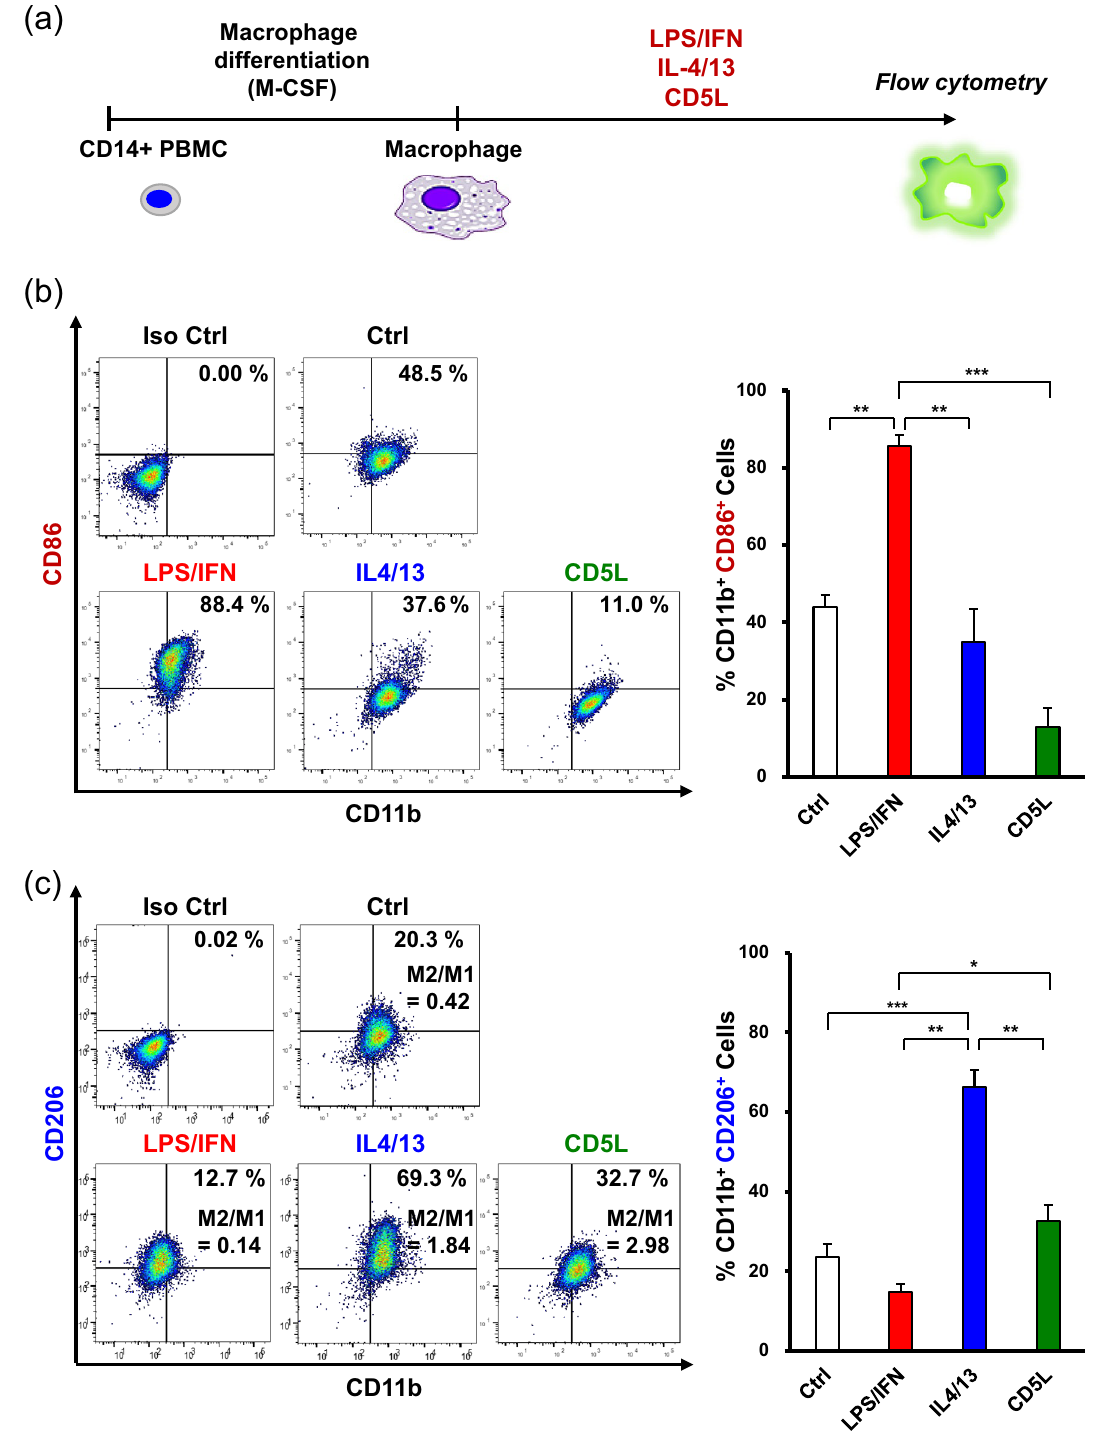
Figure 7. Recombinant CD5L enhanced M2 macrophage polarization. ( a ) Experimental diagram for CD14 + peripheral blood-derived monocytes (PBMC)-differentiated macrophage stimulation using recombinant human CD5L protein. After monocytes differentiate macrophages, cells were treated with LPS (10 ng/mL) plus of IFN-γ (25 ng/mL) (LPS/IFN), IL-4 plus IL-13 (25 ng/mL, each; IL-4/13) or of recombinant CD5L (1 μg/mL) for 72 h, respectively. ( b ) Effects of CD5L stimulation on CD86 expression in macrophages. ( c ) Percentage of double positive cells (CD11b + CD206 + ) was analyzed to measure the ratio of macrophages polarized to M2 phenotype and M2/M1 balance was determined by using the ratio of (CD11b + CD206 + )/(CD11b + CD86 + ) macrophage population. * P < 0.05; ** P < 0.01; *** P < 0.001. Error bars represent mean ± SD, n = 3. The significance of differences between groups was determined using one-way Tukey’s